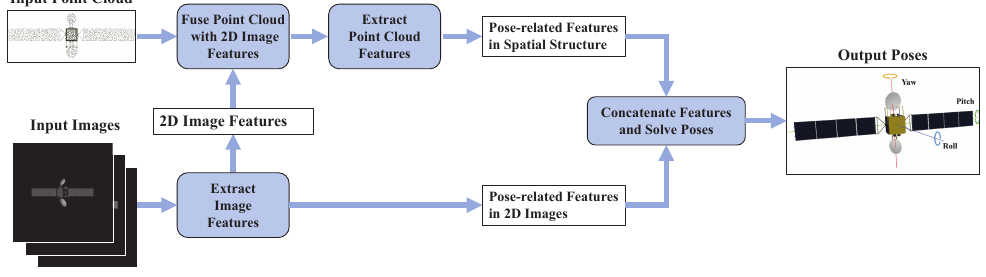
Figure 1. The overall idea of the proposed method. First, we extract the features from the input image and get pose-related features in 2D images. Then, we fuse the point cloud data with 2D features extracted from the image and obtain the pose-related features in the spatial structure. Finally, we concatenate the features together and solve the